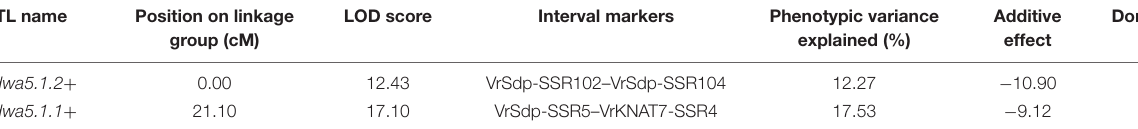
TABLE 1 | Locations and effects of quantitative trait loci on linkage group 2 controlling seed dormancy detected in the F 2 population of 575 individuals derived from hybridization between cultivated mungbean Kamphaeng Saen 2 (KPS2) and wild mungbean ACC41.